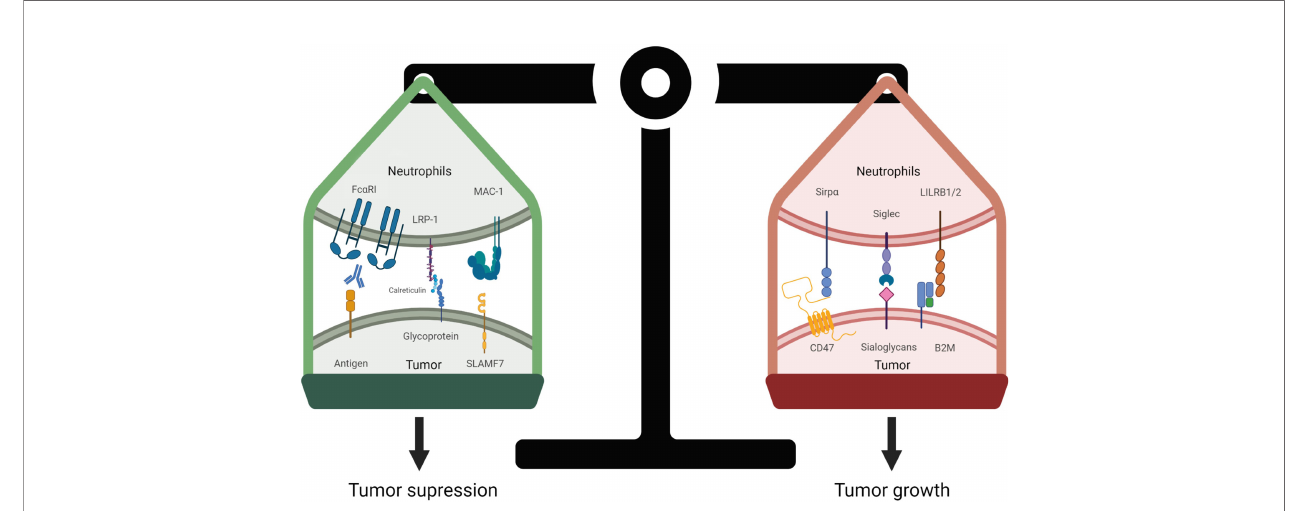
FIGURE 4 | Regulation of neutrophil-mediated tumor cell death. The balance of pro-phagocytic and anti-phagocytic signals determines the fate of the tumor cell. Pro-phagocytic signals are elicited by Fc receptor engagement to IgA-opsonized tumor cells, resulting in Fc activation and phosphorylation of downstream ITAM tyrosines. Calreticulin is tethered to the cell surface by membrane glycans and interacts with lipoprotein receptor-related protein 1 (LRP1) receptor expressed on neutrophils. Likewise, SLAMF7 (CD319) binds to macrophage-1 antigen (MAC-1, a M b 2 ), these interactions promote tumor cell killing by neutrophils. In contrast, overexpression of CD47 on tumor cells interact with SIRP a to inhibit neutrophil activation. Similarly, if expressed, the sialoglycans-Siglec axis, and HLA1 (B2M)-LILRB axis if expressed decrease immune responses, allowing tumor cells to evade immune